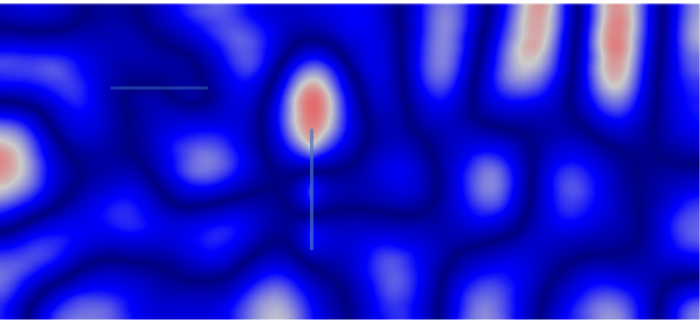
Figure 16. The absolute pressure on the whole domain at time 1.210ms. Beams are plotted with light blue color. Pressure activity is evident at the top end of the vertical